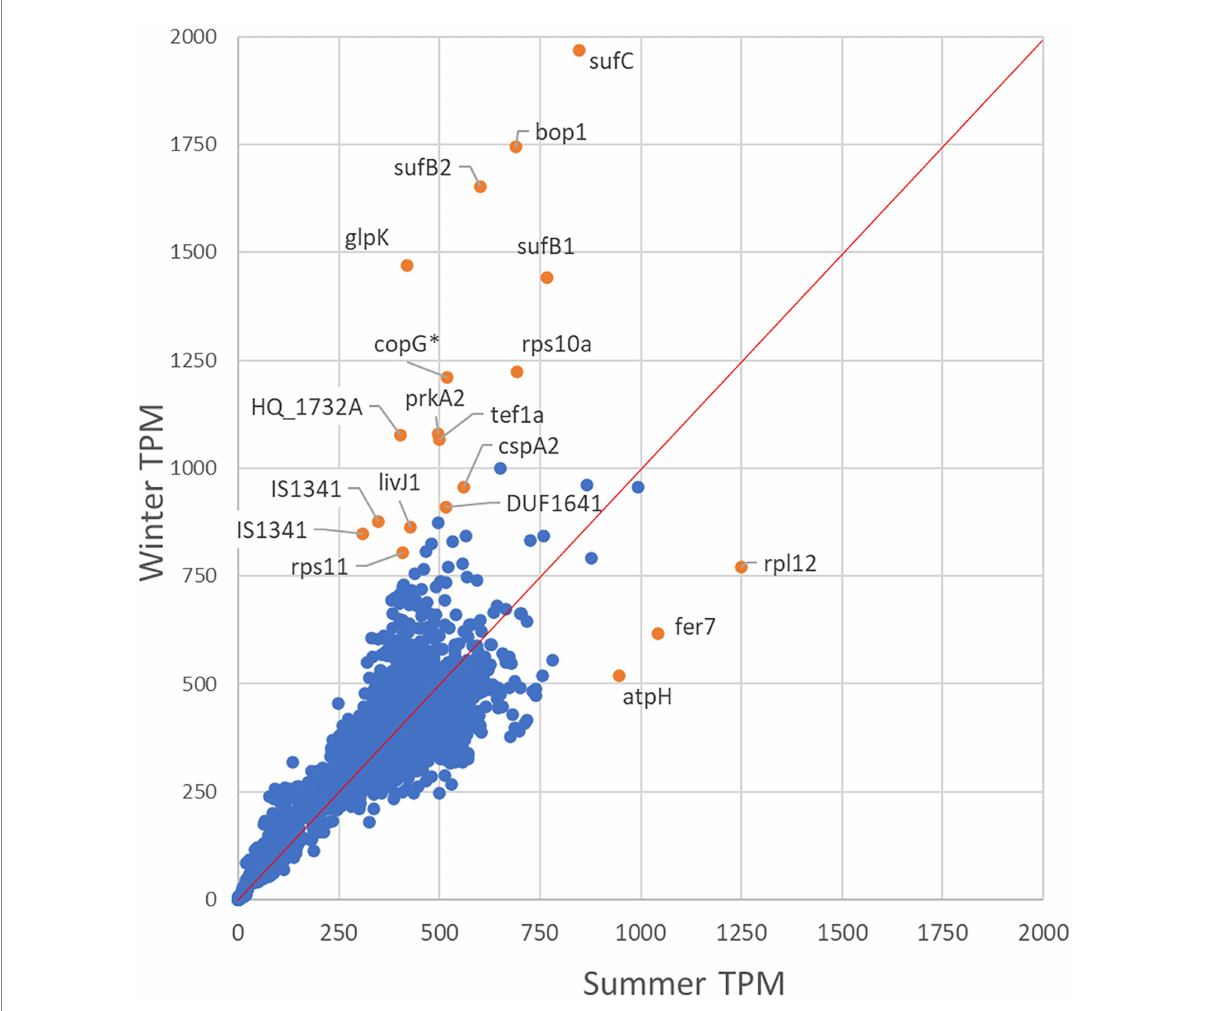
FIGURE 2 Differential expression analysis. The scatter plot shows the gene expression level in the summer (x-axis) versus the winter population (y-axis). Genes below the 1 tot 1 expression line are higher expressed in summer and above the 1 to 1 line are higher expressed in winter. Significantly differentially expressed genes are indicated in